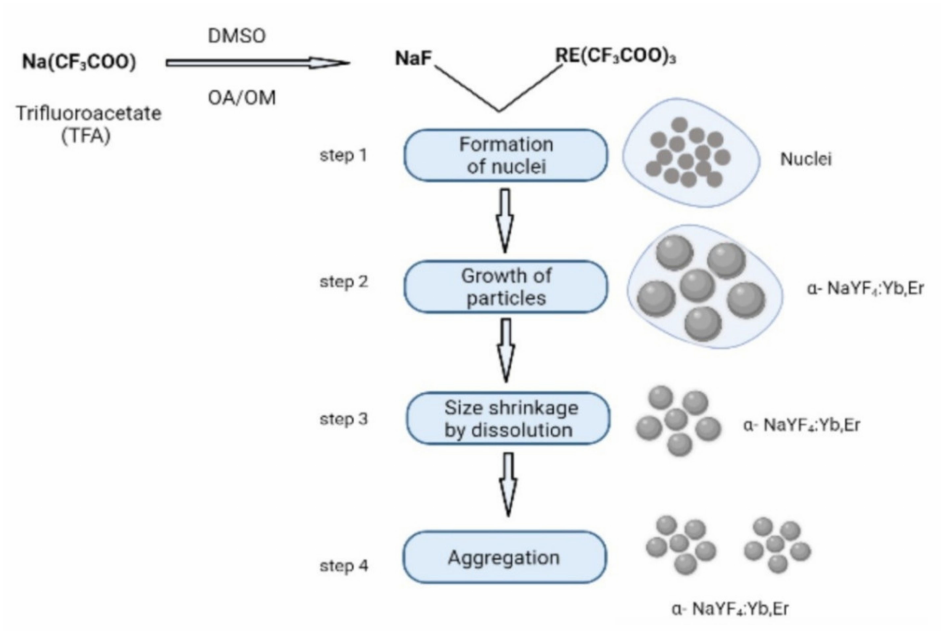
Figure 4. Synthesis of α -NaYF 4 : Yb 3+ /Tm 3+ or α -NaYF 4 : Yb 3+ /Er 3+ UCNPs via thermal decomposi- tion